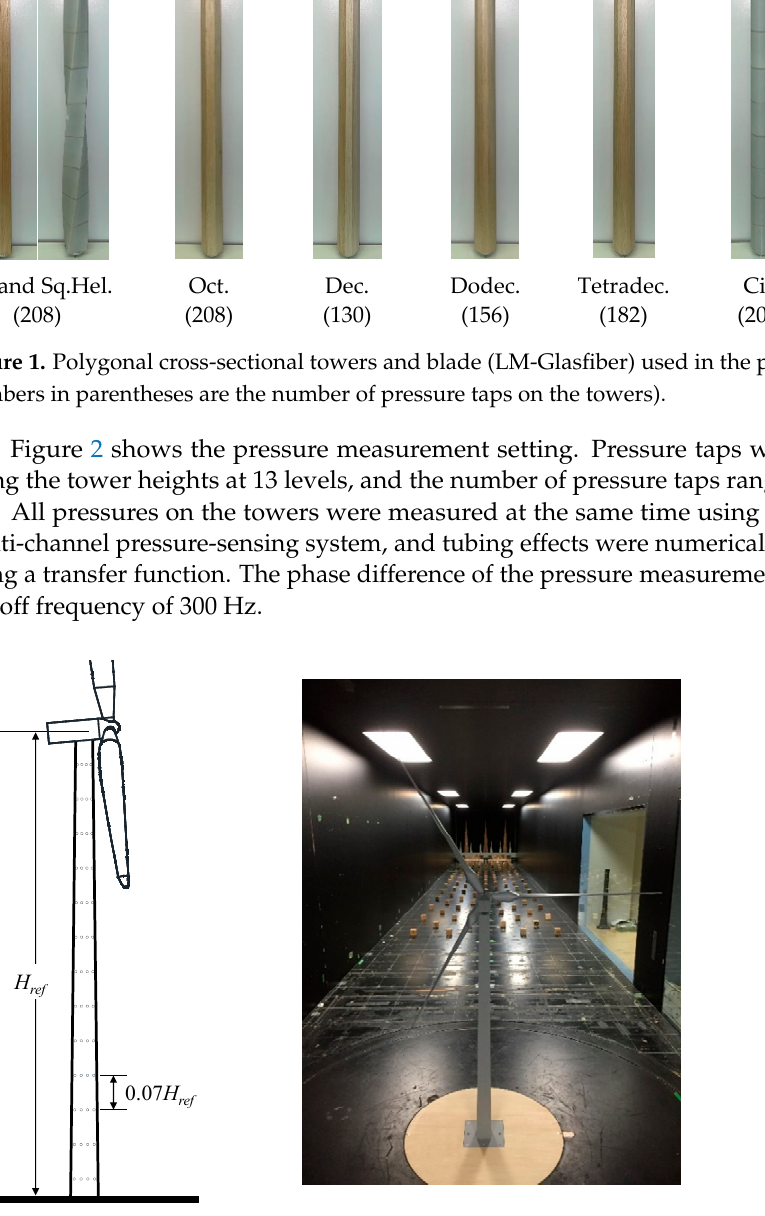
Figure 2. Pressure tap arrangement and wind turbine model with square tower ( H ref = 0.9 m).